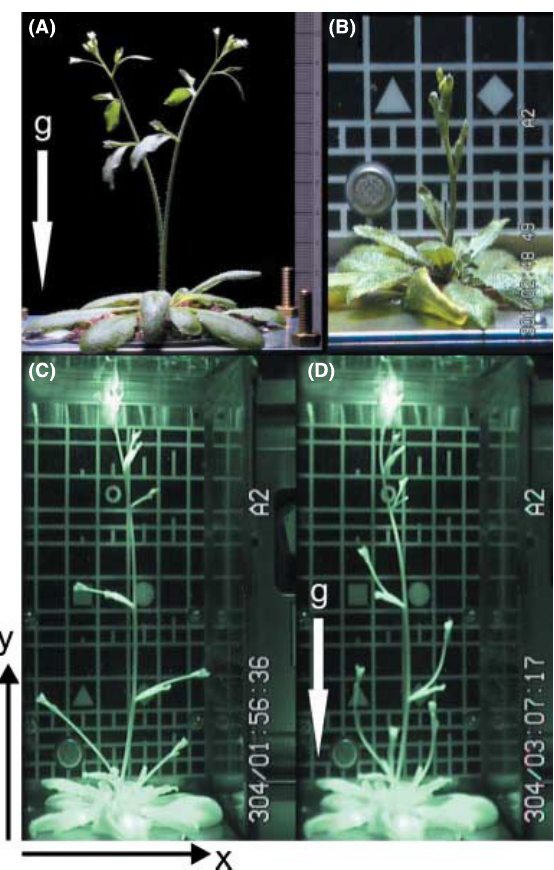
Figure 4. The picture shows an Arabidopsis thaliana plant growing in weightlessness on board the ISS in the plant cultivation chamber in the EMCS. The pictures show the different developmental stages and the effect of variable g-forces the plant can be exposed to (micro-g to 0.8 g): ( A ) 1 g on Earth with the force direction as illustrated by the arrow; ( B ) micro-g on the ISS; ( C ) micro-g on the ISS just before the centrifuges are started; ( D ) the same plant as in picture C, 70 min after the centrifuges are started, giving 0.8 g in the middle of the growth chamber with directions as illustrated by the arrow. For further details, see